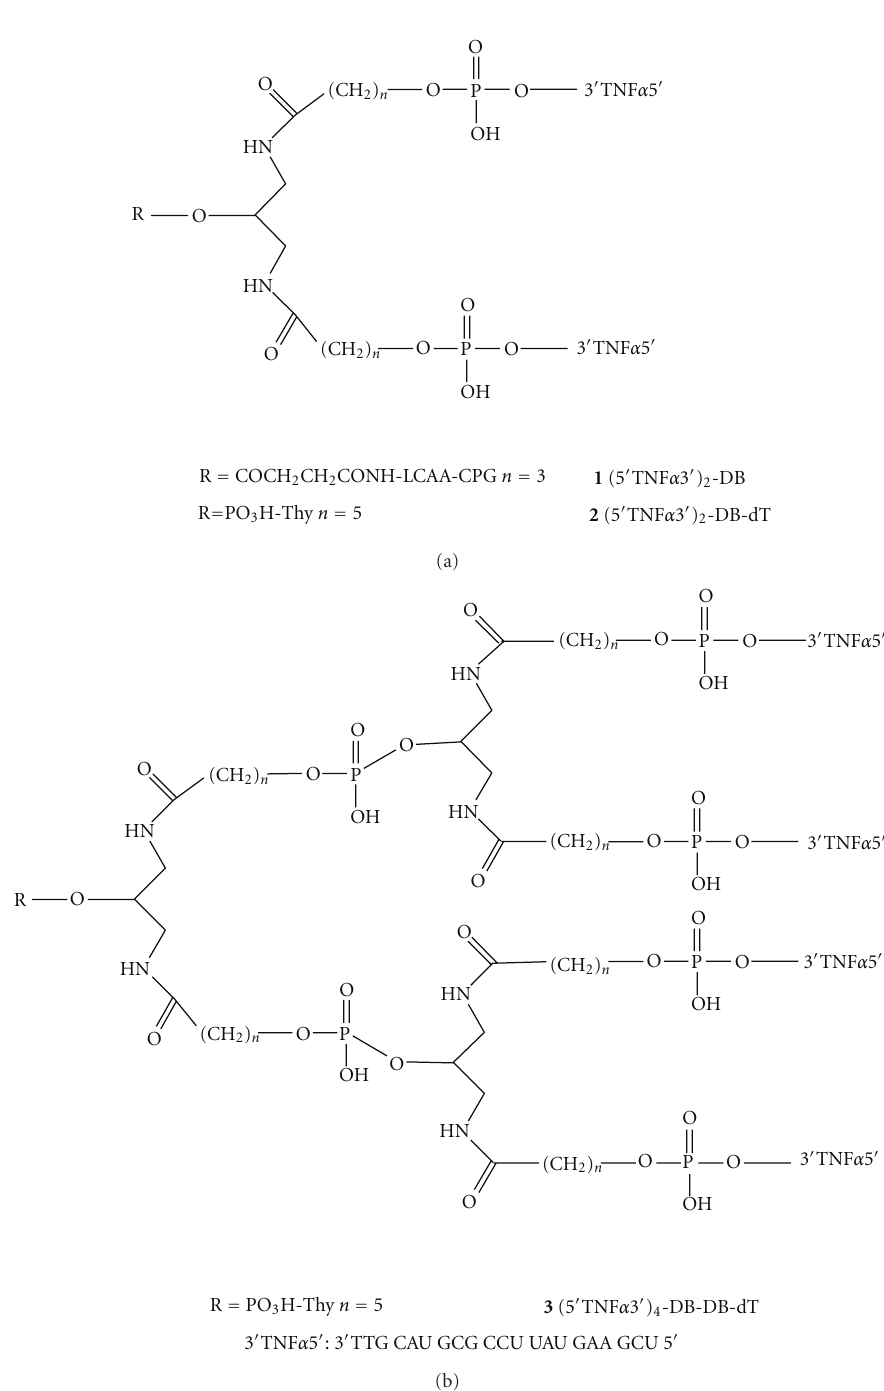
measurements were repeated three times and conducted in 15 mM HEPES 1 mM Mg(OAc) 2 and 50 mM KOAc pH 7.4. 2.3. Cell Culture, Transfection, and Cellular Assays. HeLa cells were cultured under standard conditions (37 ◦ C, 5% CO 2 , Dulbecco’s Modified Eagle Medium, 10% fetal bovine serum, 2 mM L-glutamine, supplemented with penicillin